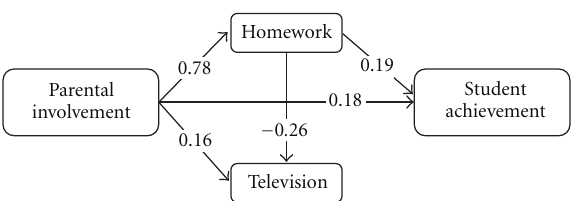
Figure 5: Relationship between PI and achievement with homework and television viewing as mediating variables. Note: adapted from “Does parental involvement a ff ect eighth-grade student achievement? Structural analysis of national data,” by T. Z. Keith, P. B. Keith, G. C. Troutman, P. G. Bickley, P. S. Trivette, and K. Singh, 1993, School Psychology Review , 22 (3), p.